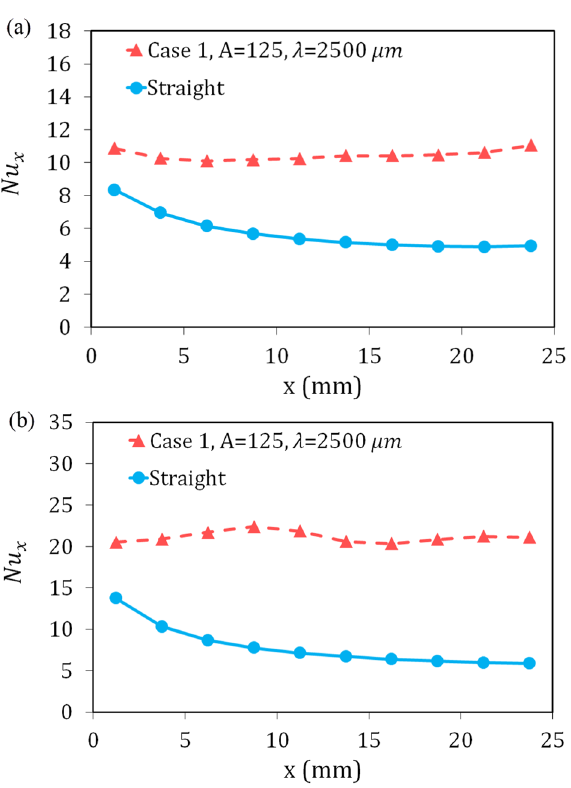
Figure 11. Velocity and temperature distribution with representing velocity vectors for wavy case 1 (A = 125 μm, λ = 2500 μm), ( a – c ) at longitudinal distance of 1.25 mm, 11.25 mm,and 23.75 mm from microchannel inlet and Re = 300, and ( d – f ) at longitudinal distance of 1.25 mm, 11.25 mm ,and 23.75 mm from microchannel inlet and Re = 900.